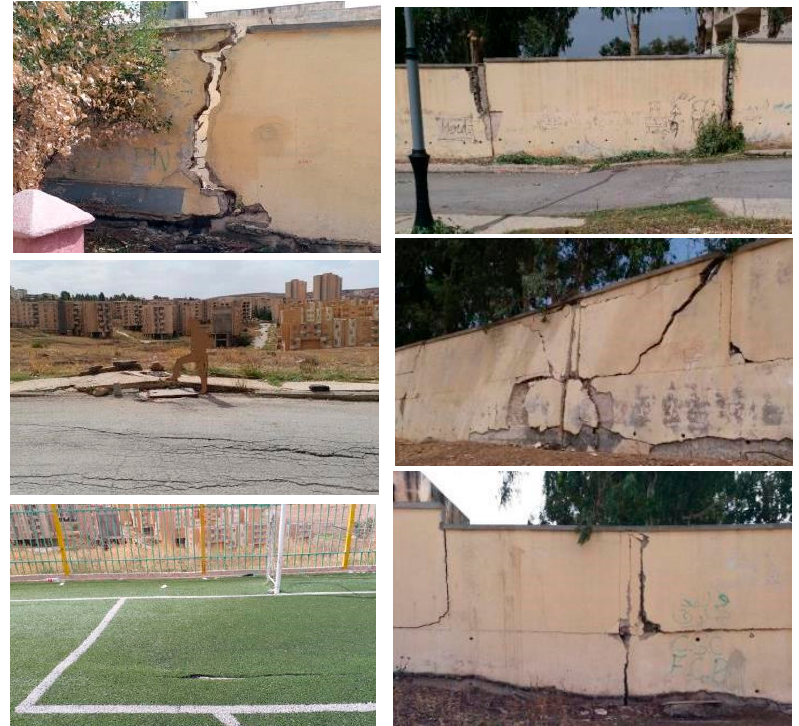
Figure 14. Damaged school at the Boussouf district.